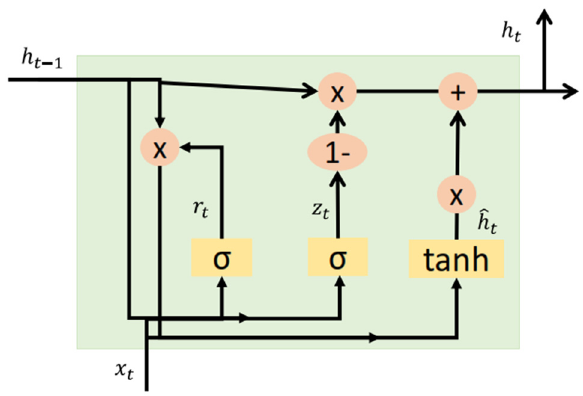
Figure 3. Base neuron GRU [39].